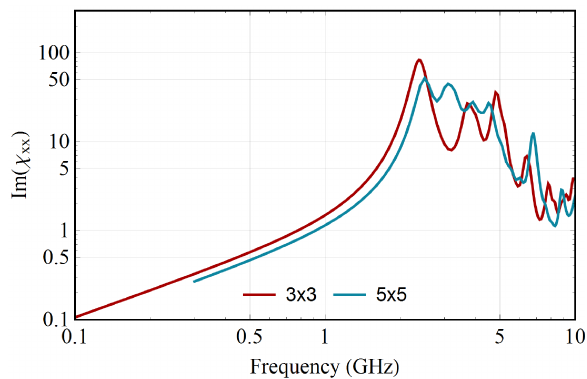
Figure 9. Ordered arrays of nanoplatelets with an o ff -centered macro-vortex state without a vortex core. Im χ xx spectra for two array sizes 3 × 3 and 5 × 5. Regime of weak dipolar coupling ( δ = 15